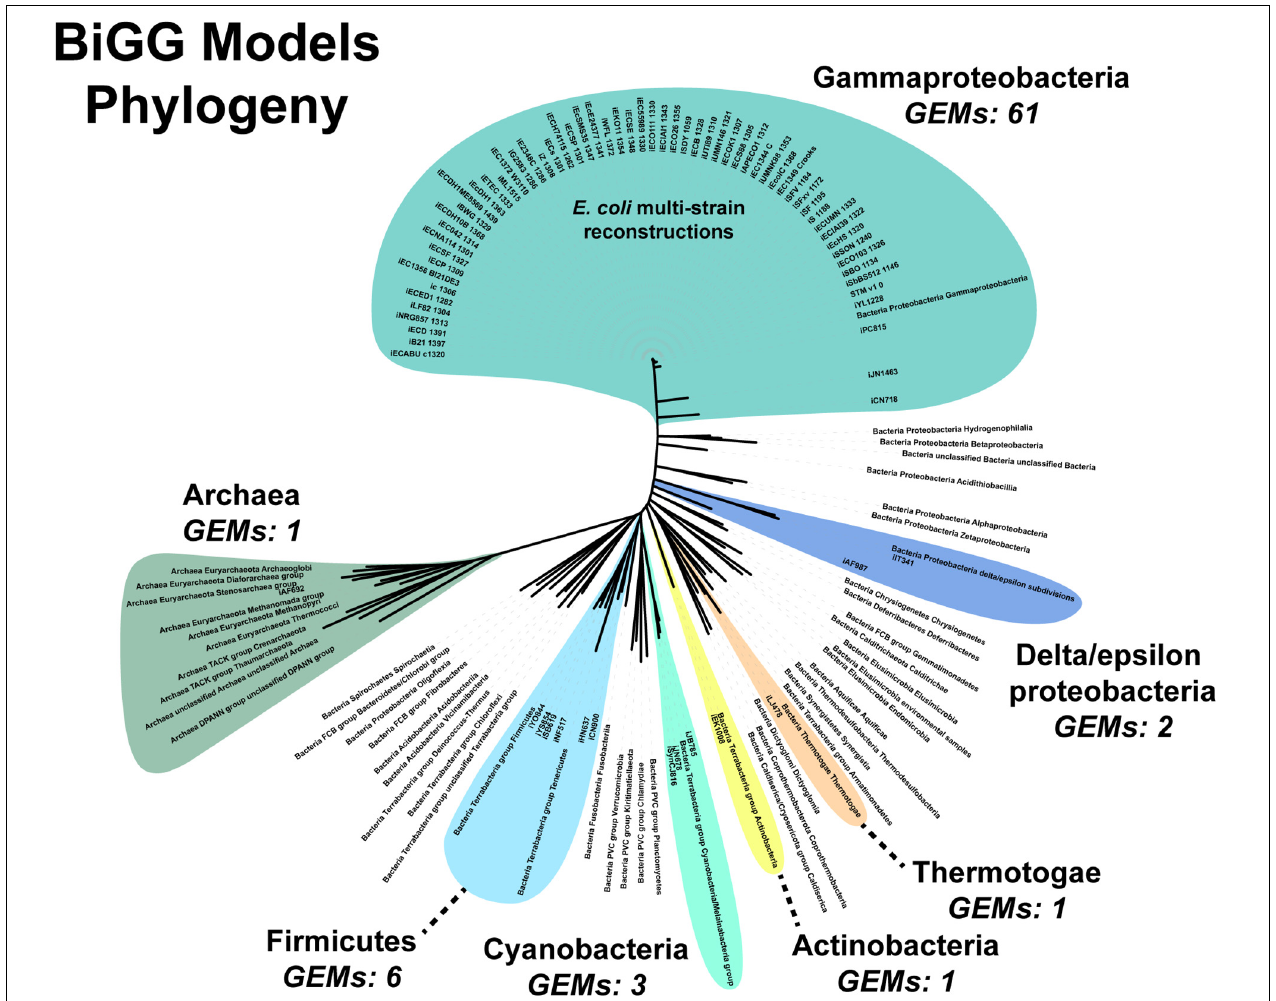
FIGURE 6 | Phylogenomic analysis of genome scale models in the BiGG Models